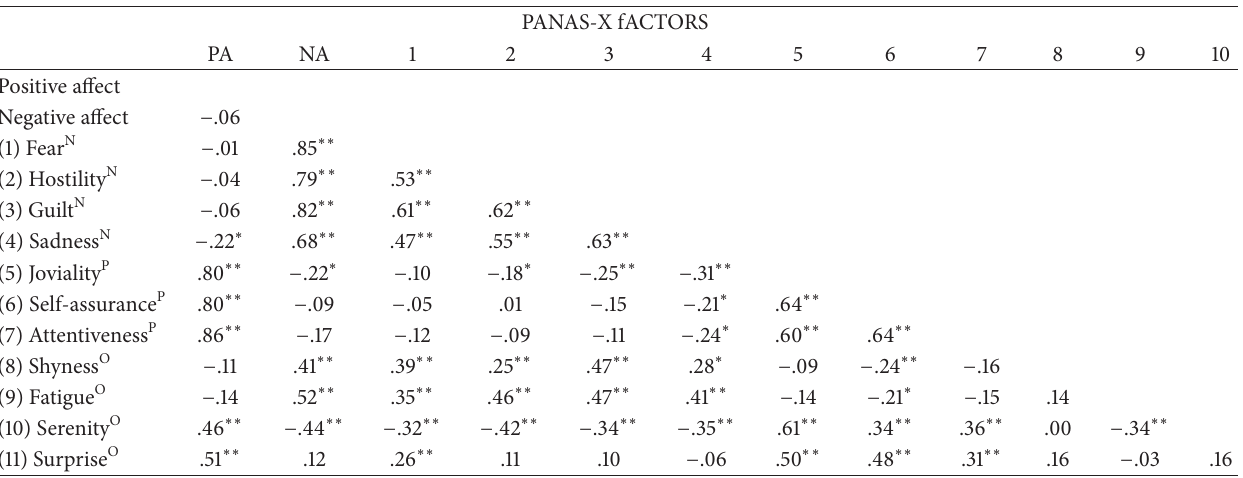
Table 4: Correlation matrix of PANAS-X factors.